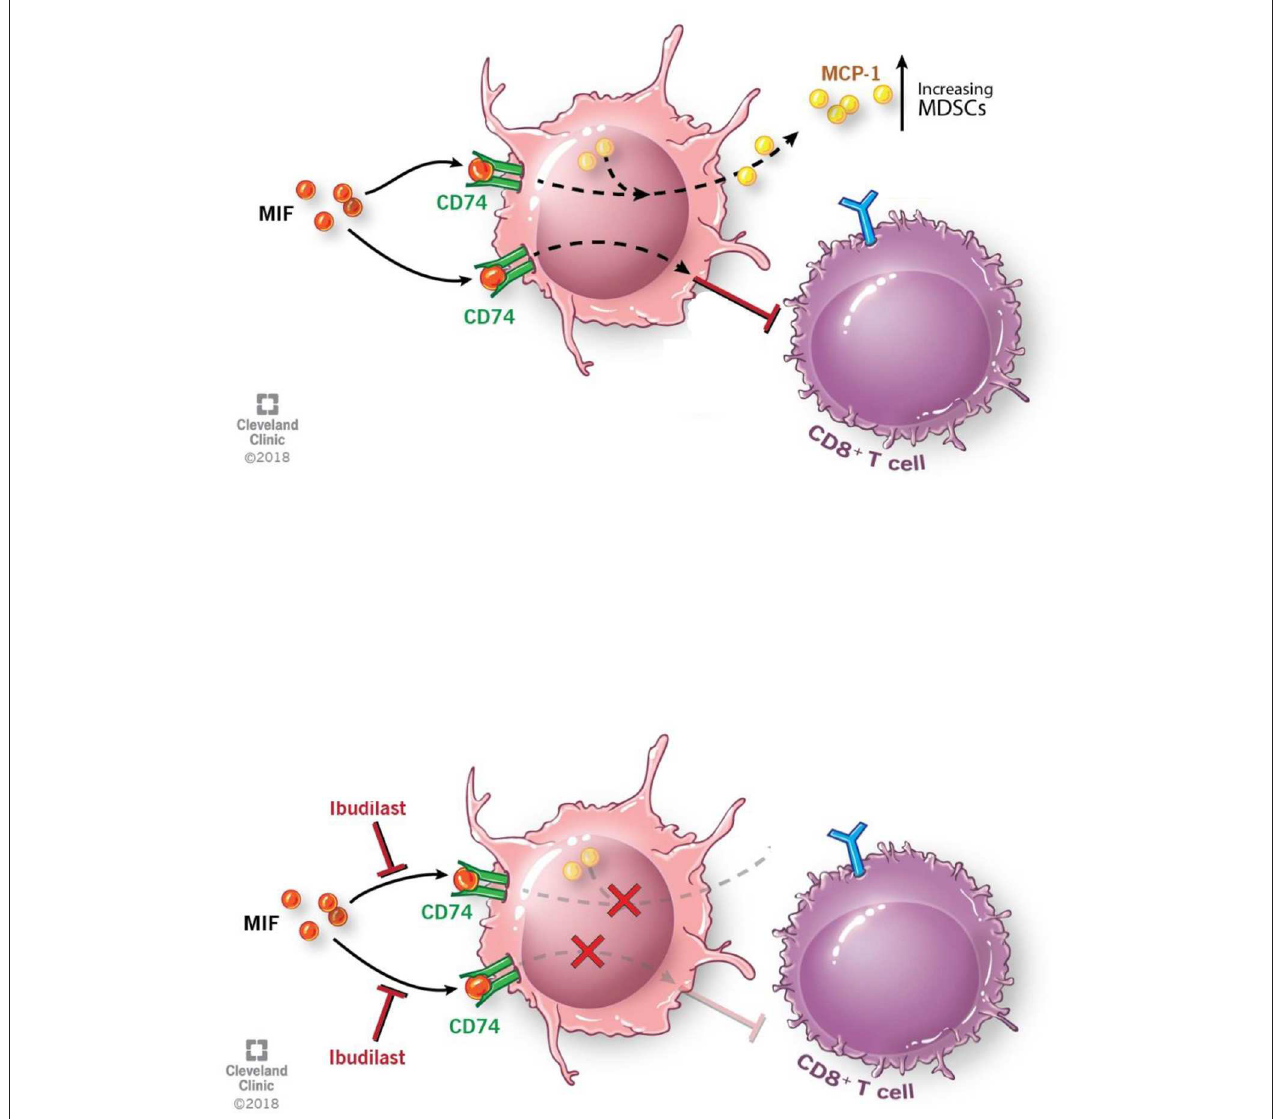
FIGURE 6 | Schematic depicting pathway described where MIF binds CD74 on M-MDSCs enhancing their activity to inhibit CD8T cells and also produce the downstream target MCP-1. With the addition of Ibudilast to inhibit this process we show a reduction of the MDSCs generation and function removing the inhibitor effect from CD8T